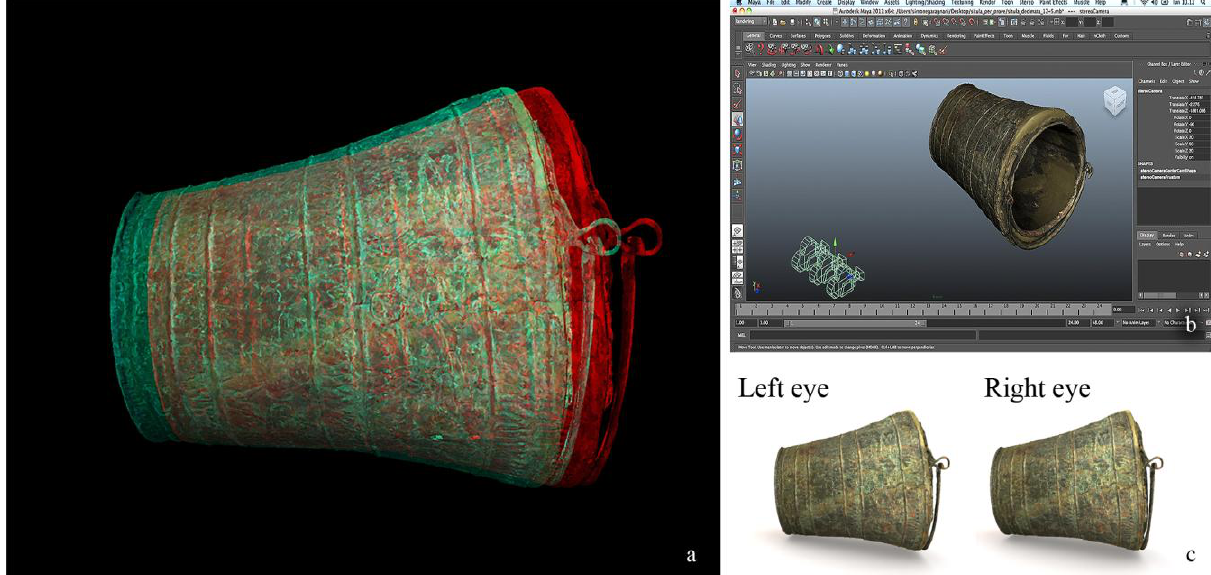
Figure 9. Studies on stereoscopic visualization of situla Arnoaldi: red-cyan glasses were experimented to view anaglyph images correctly through passive techniques (a), using the StereoCamera rig option in Autodesk® Maya® (b). Then, taking advantage of Nvidia® 3D Vision® active technology, eye-splitted renders of the textured model were composed as intended in a typical JPS format layout (c) and displayed with synced glasses, with neutral saturation and full spectrum